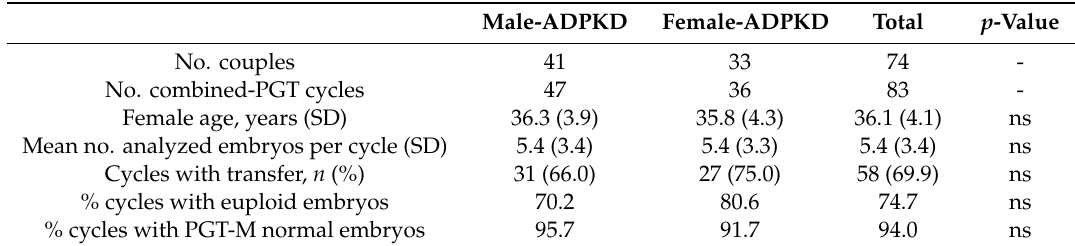
Table 1. Results per cycle presented by cases where the female (female-autosomal dominant polycystic kidney disease (ADPKD)) or the male (male-ADPKD) carried the ADPKD mutation. Male-ADPKD